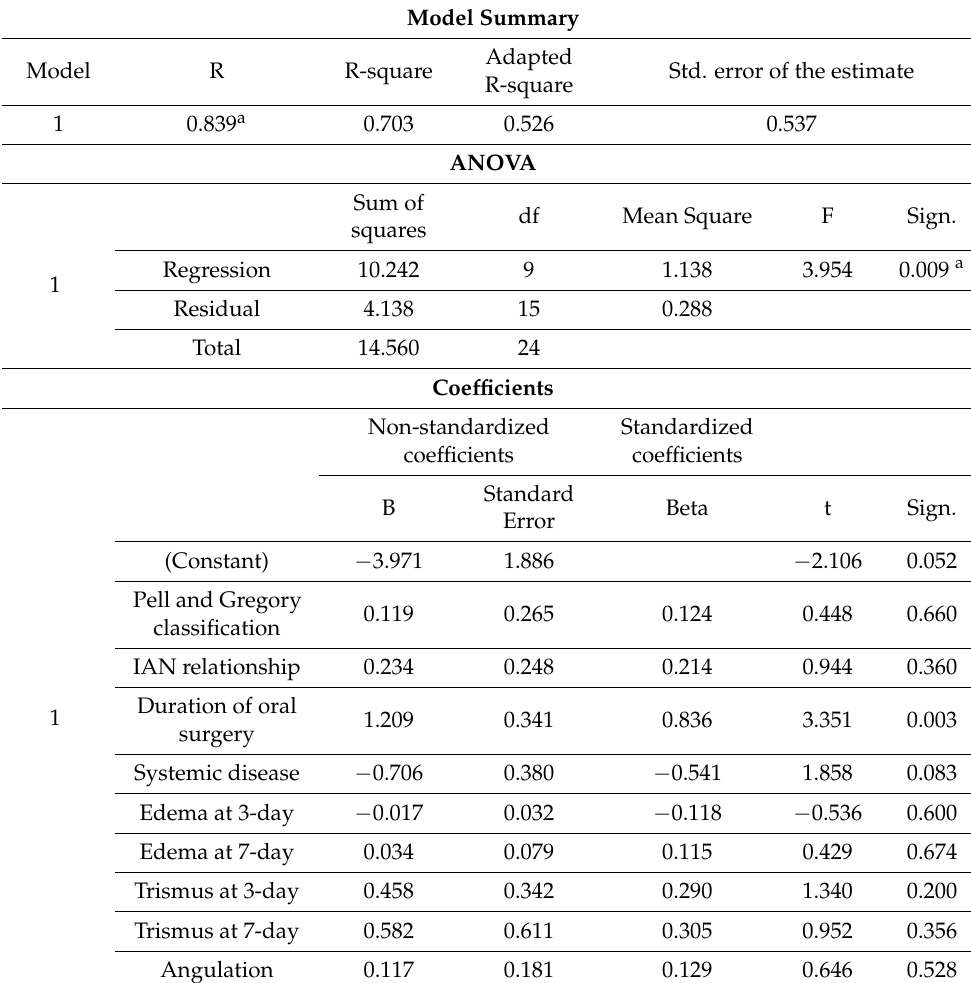
Table 9. Correlation between VAS scores at 12 h and patient- and tooth-related factors.